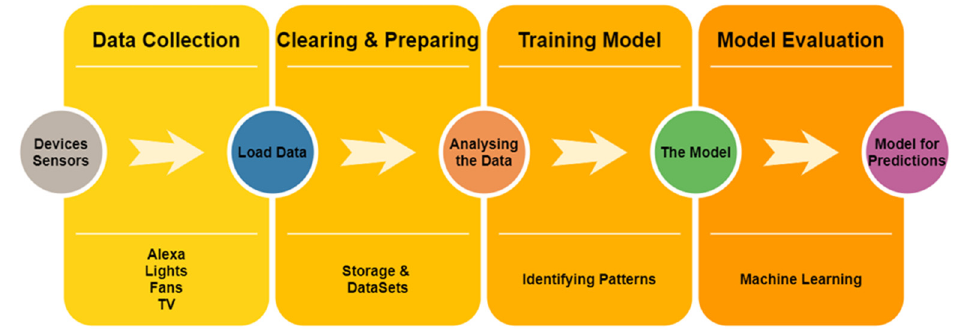
Figure 2. Logical architecture of modelling big data and personalisation.